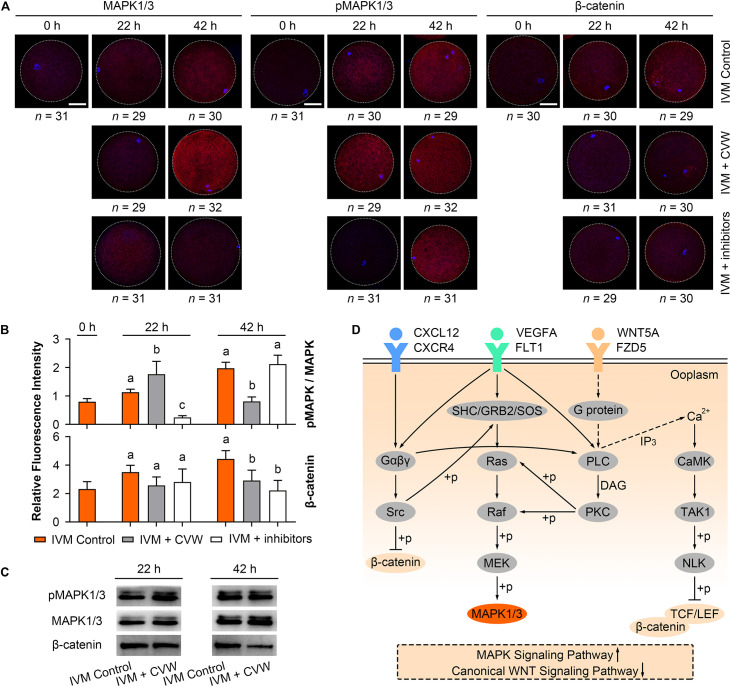
Effects of CVW and their receptor inhibitors on MAPK and canonical WNT pathway during IVM. (A) Immunostaining of MAPK1/3, phosphorylated MAPK1/3 (pMAPK1/3), and β-catenin (red) and DAPI (blue) in control, CVW-treated, and inhibitor-treated oocytes at 0, 22, 42 h during IVM. Scale bar = 30 μm. (B) Bar plots show the fluorescence intensities of pMAPK/MAPK and β-catenin in control, CVW-treated, and inhibitor-treated oocytes at 0, 22, 42 h during IVM. Error bars represent the SD in three replicates. Different superscripts indicate P < 0.05 (one-way ANOVA with Duncan’s test). (C) Representative images of immunoblots showing the signal intensities of MAPK, pMAPK and β-catenin in control and CVW-treated oocytes at 22 and 42 h during IVM. (D) Schematic representation of the proposed mechanism illustrating the interactions between CVW and their receptors on the oolemma, as well as the downstream signaling pathways regulated by CVW. Signal transduction pathways are summarized from the KEGG database (https://www.kegg.jp/). Dashed arrows stand for putative interactions. Oocyte maturation improvement by CVW is achieved through activating the MAPK pathway, as well as inhibiting the canonical WNT pathway during IVM.